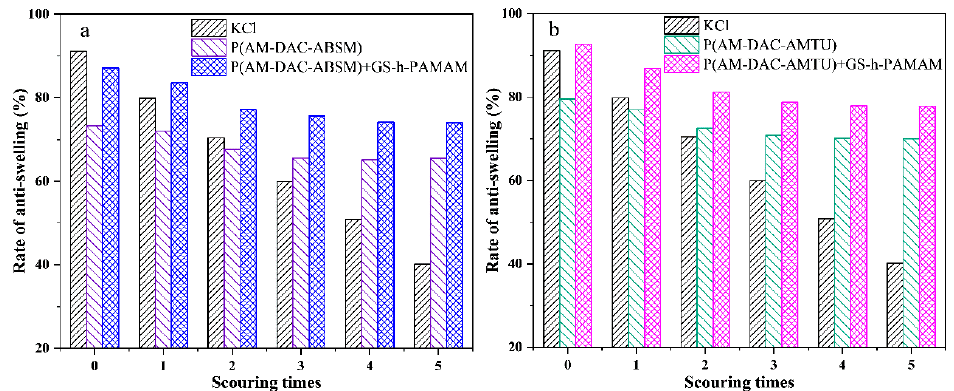
Figure 8. Effect of scouring times on rate of anti-swelling: (a) KCl, P(AM-DAC-ABSM) and its supramolecular system; (b) KCl, P(AM-DAC-AMTU) and its supramolecular system.